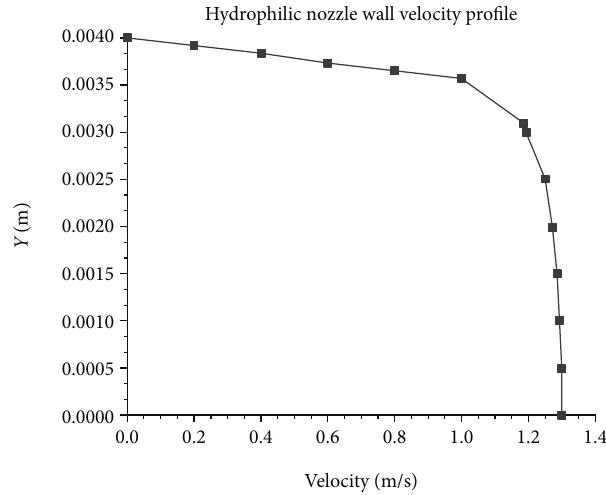
Figure 8: Hydrophilic wall velocity pro fi